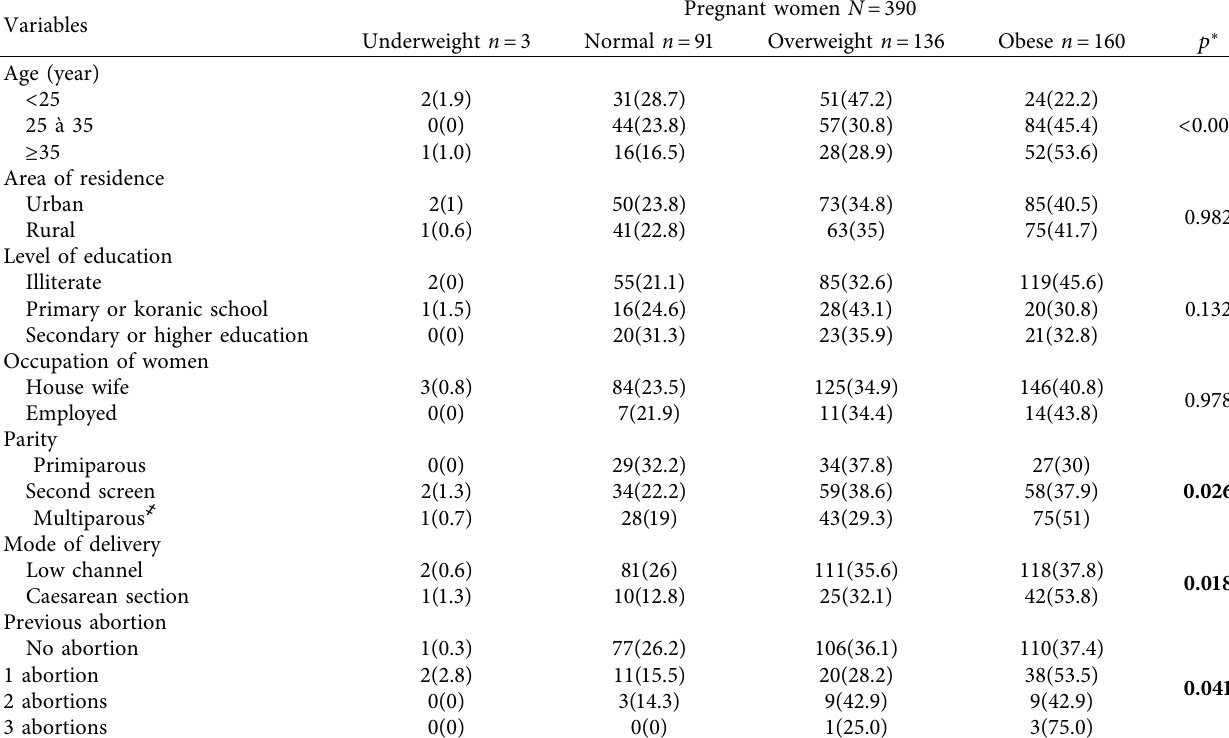
Table 4: Distribution of female partners by sociodemographic, obstetric, and body size parameters.